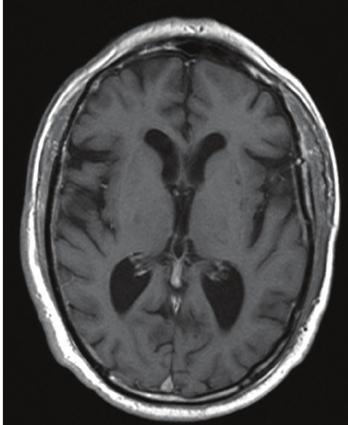
Figure 2: MRI T1—lacunar infarction in left